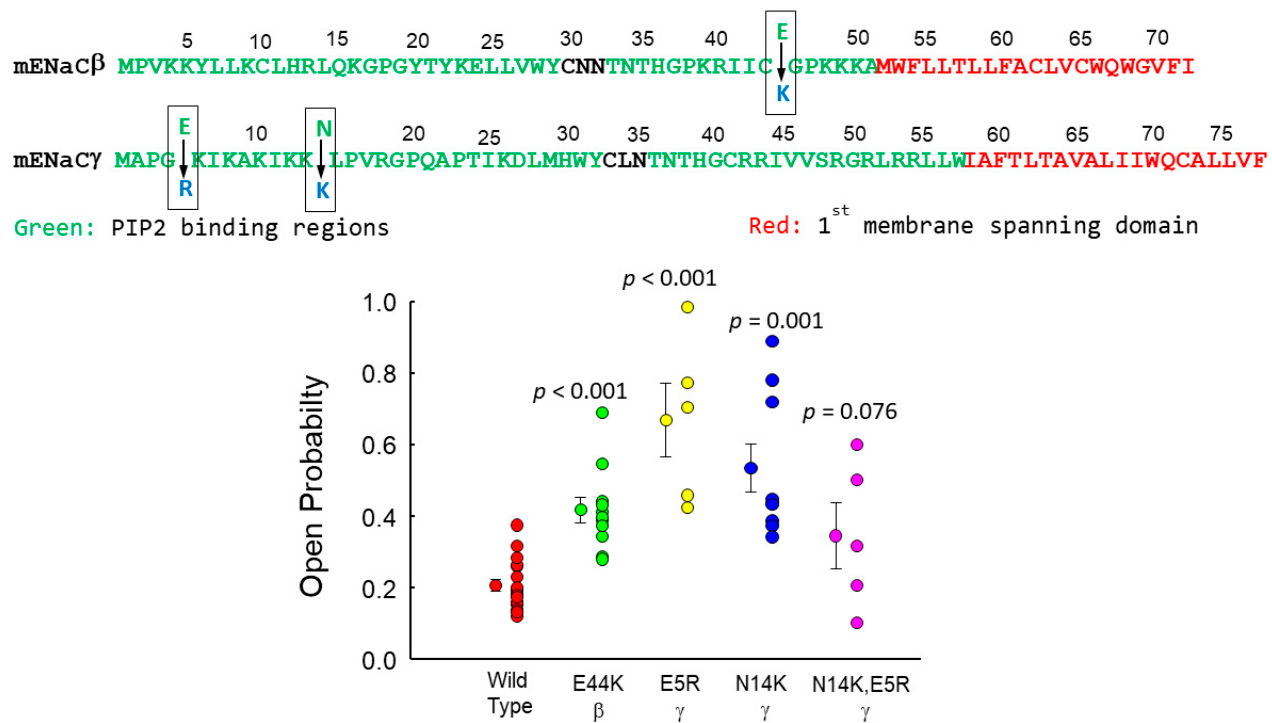
Figure 10. Altering the charge structure of β or γ ENaC PIP 2 -binding domains changes ENaC open probability. We made four mutations that increased the positive charge of PIP 2 binding domains in β or γ ENaC: β E45K, γ E5R, γ N14K, and γ N14K, E5R. There is negatively charged glutamate in the middle of the sequence of cationic residues at position E45, which we have mutated to a positively charged lysine. For γ , we made one single mutation, E5R, a negative charge to a positive charge, and a double mutation, γ N14K, E5R. We transfected H441 with α -ENaC, one of the mutant ENaCs, and the other wild-type ENaC subunits. After transfection, we formed excised patches and applied 30 μ M PIP2 to the cytosolic surface of the patch and examined the open probability of the patches. All four mutants increased ENaC open probability above that of wild-type subunits, but only the β E45K, γ E5R, and the γ N14K mutants increased the open probability significantly from wild-type. Wildtype Po is 0.236 ± 0.0744 (n = 11); β E45K is 0.418 ± 0.116 (n = 11, p = 0,014); γ E5R is 0.644 ± 0.259 (n = 5, p < 0.001); and γ N14K is 0.535 ± 0.204 (n = 9, p < 0.001) and γ N14K E5R 0.346 ± 0.205 (n = 5; p = 0.176). All compared to wild-type. Symbols represent individual experiments; sym-